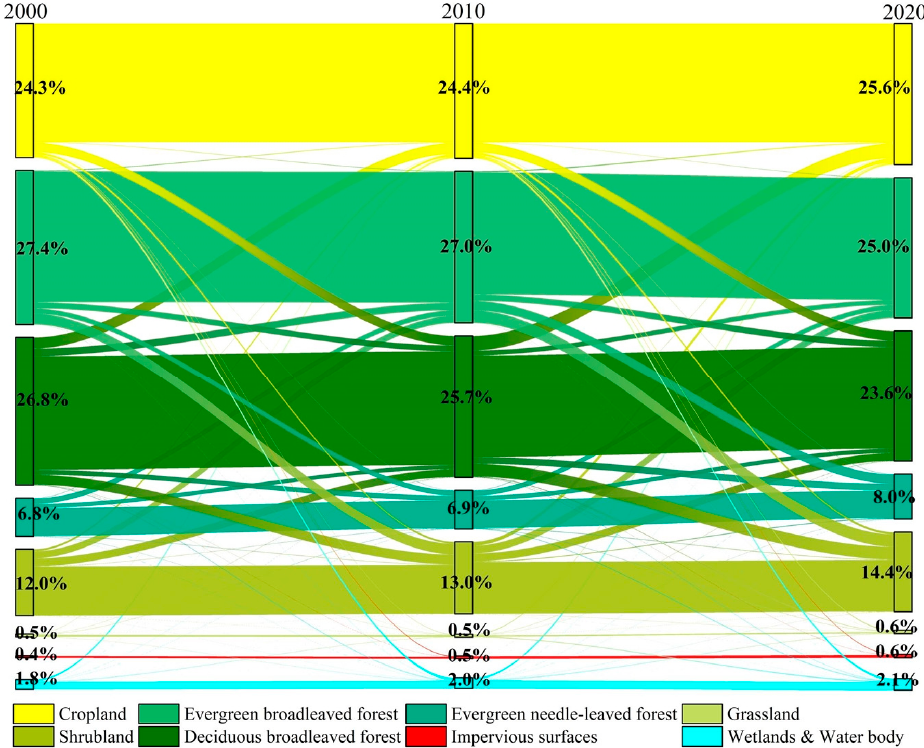
Figure 4. Conversion between different LUC types in Myanmar from 2000 to 2020.